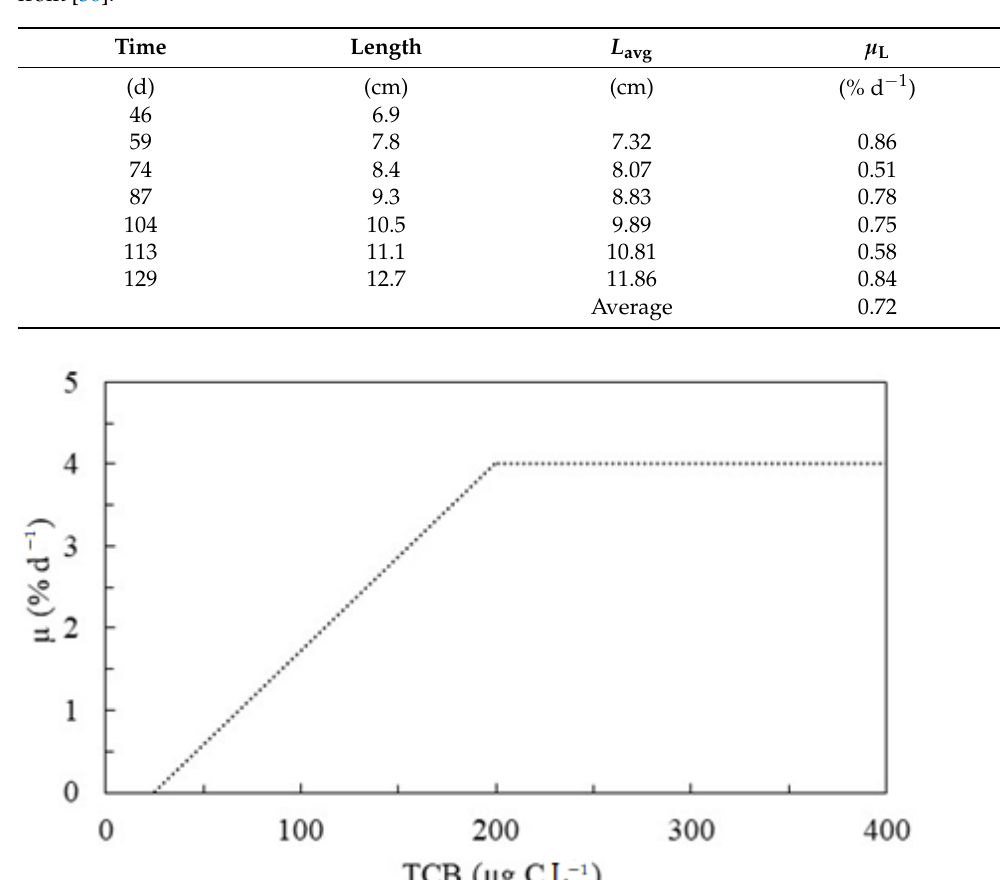
Table A4. Neopetrosia sp. Growth data in terms of specimen length obtained by replotting data from [36].